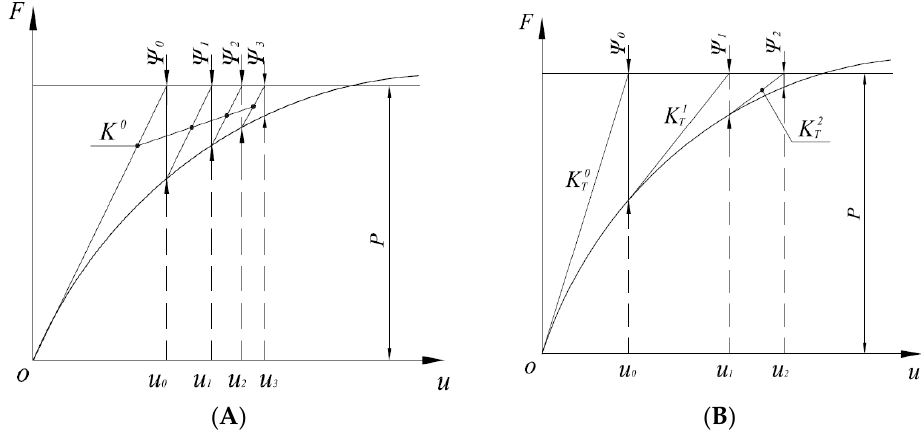
Figure 2. ( A ) Constant stiffness method, ( B ) Tangent stiffness method. The tangent stiffness method is adopted in this